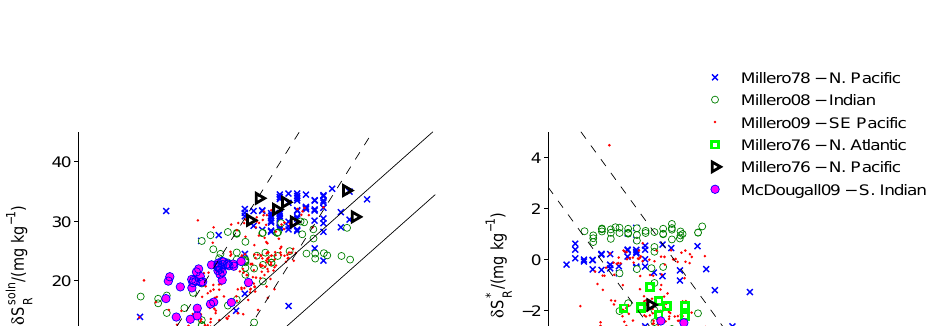
. Dashed curves show a relationship with β soln R ) =− 2 . 1, with measured density offsets of ± 0.004g m − 3 . R